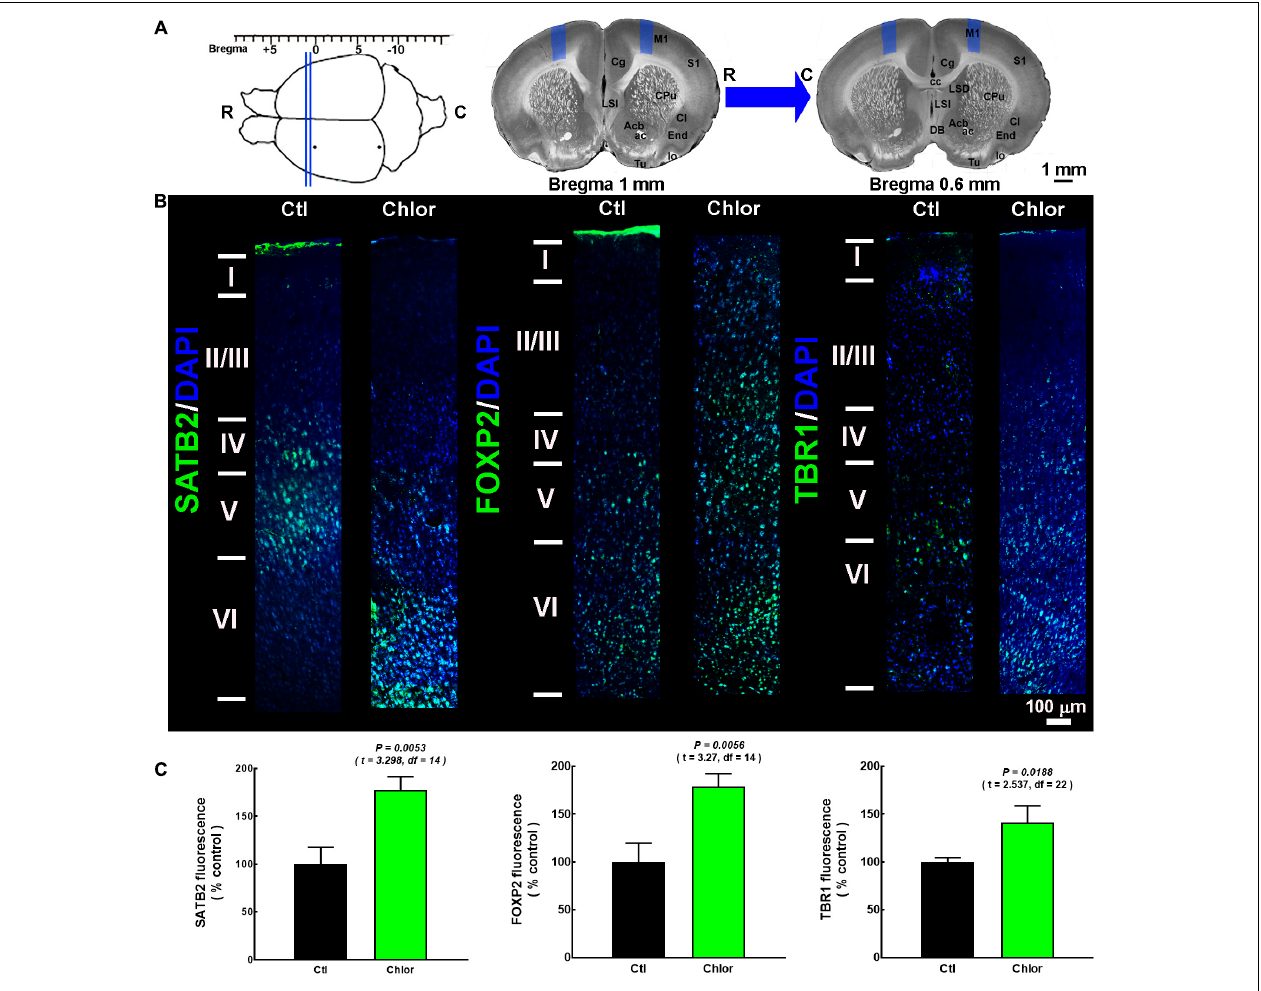
FIGURE 2 | SATB2, FOXP2, and TBR1 distribution in the primary motor cortex of 21-day-old offspring from control and chlorpheniramine-treated dams. ( A , Upper left) The image shows the coordinates (from bregma) used for immunofluorescence analysis (between the blue lines). (Upper right) The blue areas represent the zone where micrographs were taken of slices (1.0–0.6 mm from bregma, as indicated by the blue arrow). R, rostral; C, caudal. Modified from Khazipov et al. (2015). (B) Representative M1 reconstruction from seven micrographs (10 × ) of SATB2, FOXP2, and TBR1 (green) immunodetection and DAPI-stained nuclei (blue), at postnatal day 21 in the primary motor cortex from Control (Ctl) and chlorpheniramine-treated (Chlor) groups. Images are representative from 3–6 P21 animals. (C) Quantitative fluorometric analysis. Values are expressed as a percentage of the fluorescence obtained in the controls and are means ± SEM from 3–6 P21 animals. The statistical analysis was performed with unpaired Student’s t